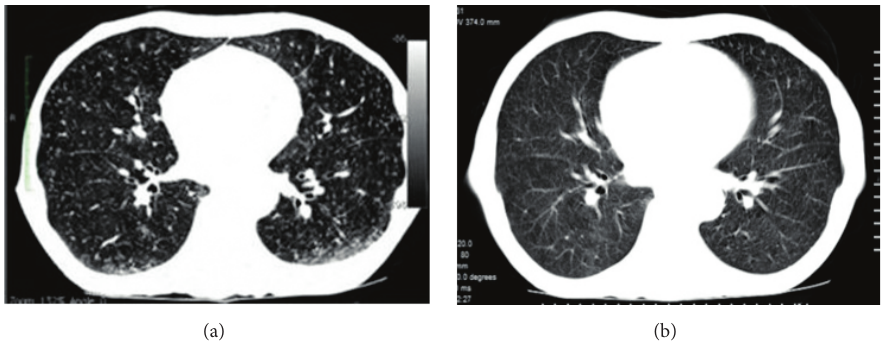
Figure 1: Chest CT images at (a) presentation and (b) fifth month of anti-TB treatment.